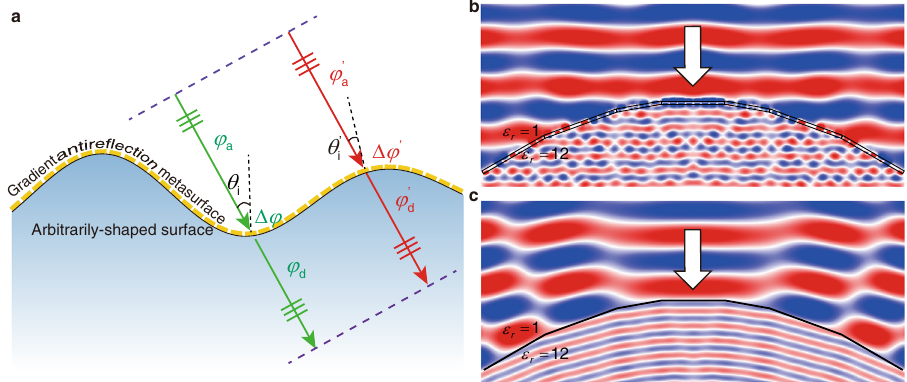
Fig. 4 Invisible curved surface. a Schematic of the arbitrarily-shaped invisible surface enabled by GAMs. Two dashed lines represent the wavefront of the incident and transmitted waves separately. Green and red arrows depict two light rays impinging on the GAM at different locations. b , c Simulated E z fi eld distributions for a curved dielectric surface with ( b ) and without ( c ) the designed GAM under the illumination of a